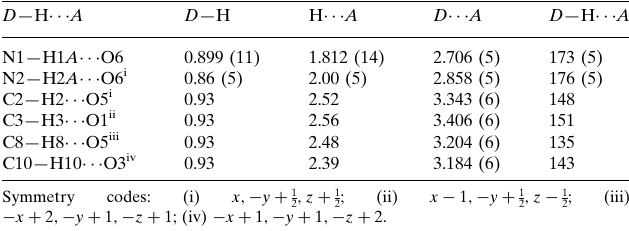
Hydrogen-bond geometry (A˚ , (cid:3)